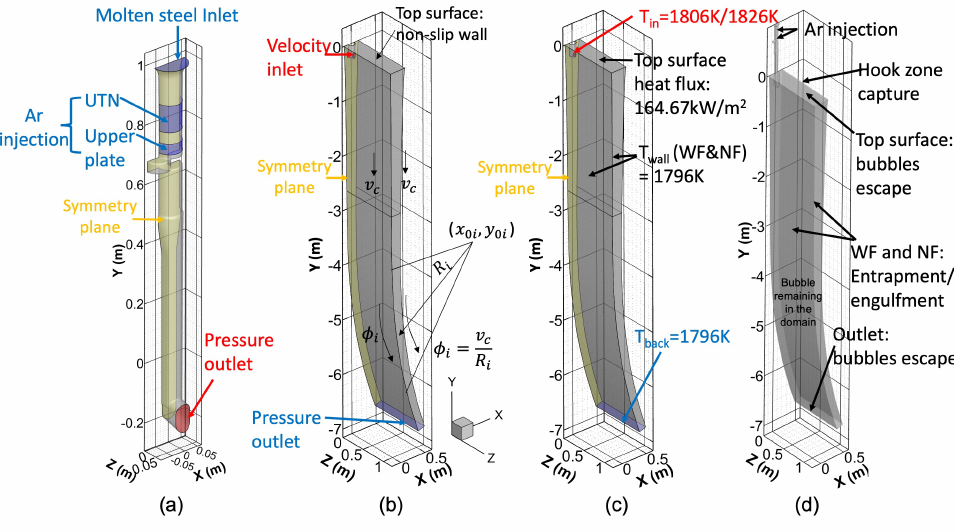
Figure 7. Boundary conditions for ( a ) step 1: nozzle flow, ( b ) step 2: strand flow, ( c ) step 3: heat transfer, and ( d ) step 4: bubble transport and